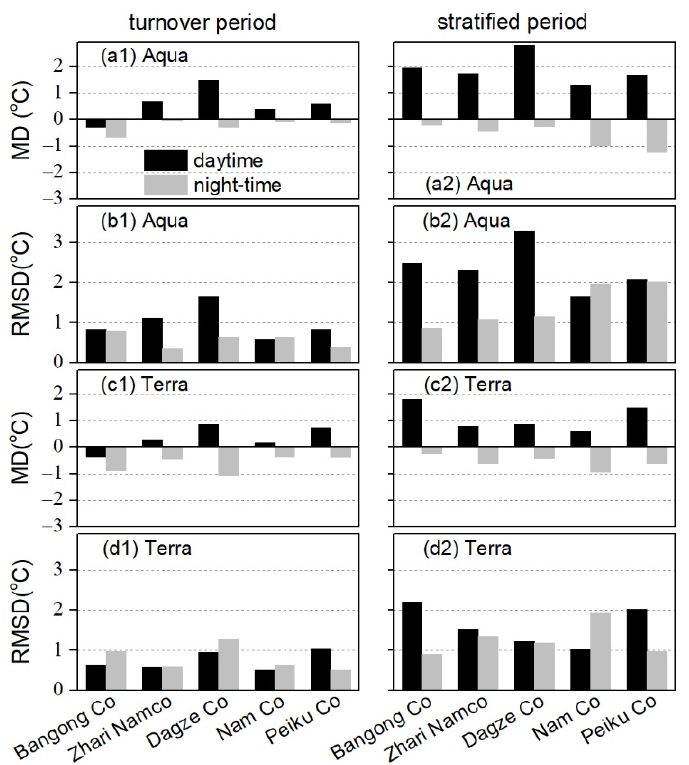
Figure 3. Mean difference (MD ( a1,a2,c1,c2 )) and root mean square difference (RMSD ( b1,b2, d1,d2 )) between MODIS LSWT and in-situ data in the daytime and at night, (1) during the lake turnover period, (2) during the lake stratified period, for Aqua ( a1,a2,b1,b2 ) and Terra ( c1,c2,d1,d2 ), in the five large lakes on the